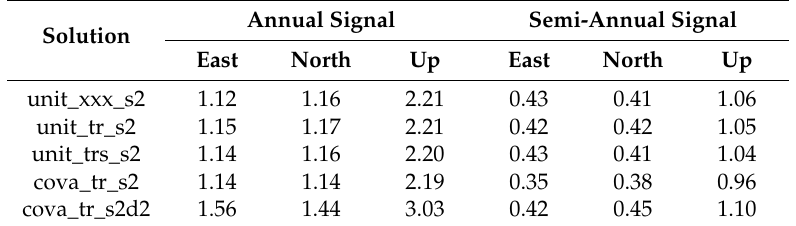
Table 2. RMS misfit of GNSS position series stacking solutions with different strategies. (unit: